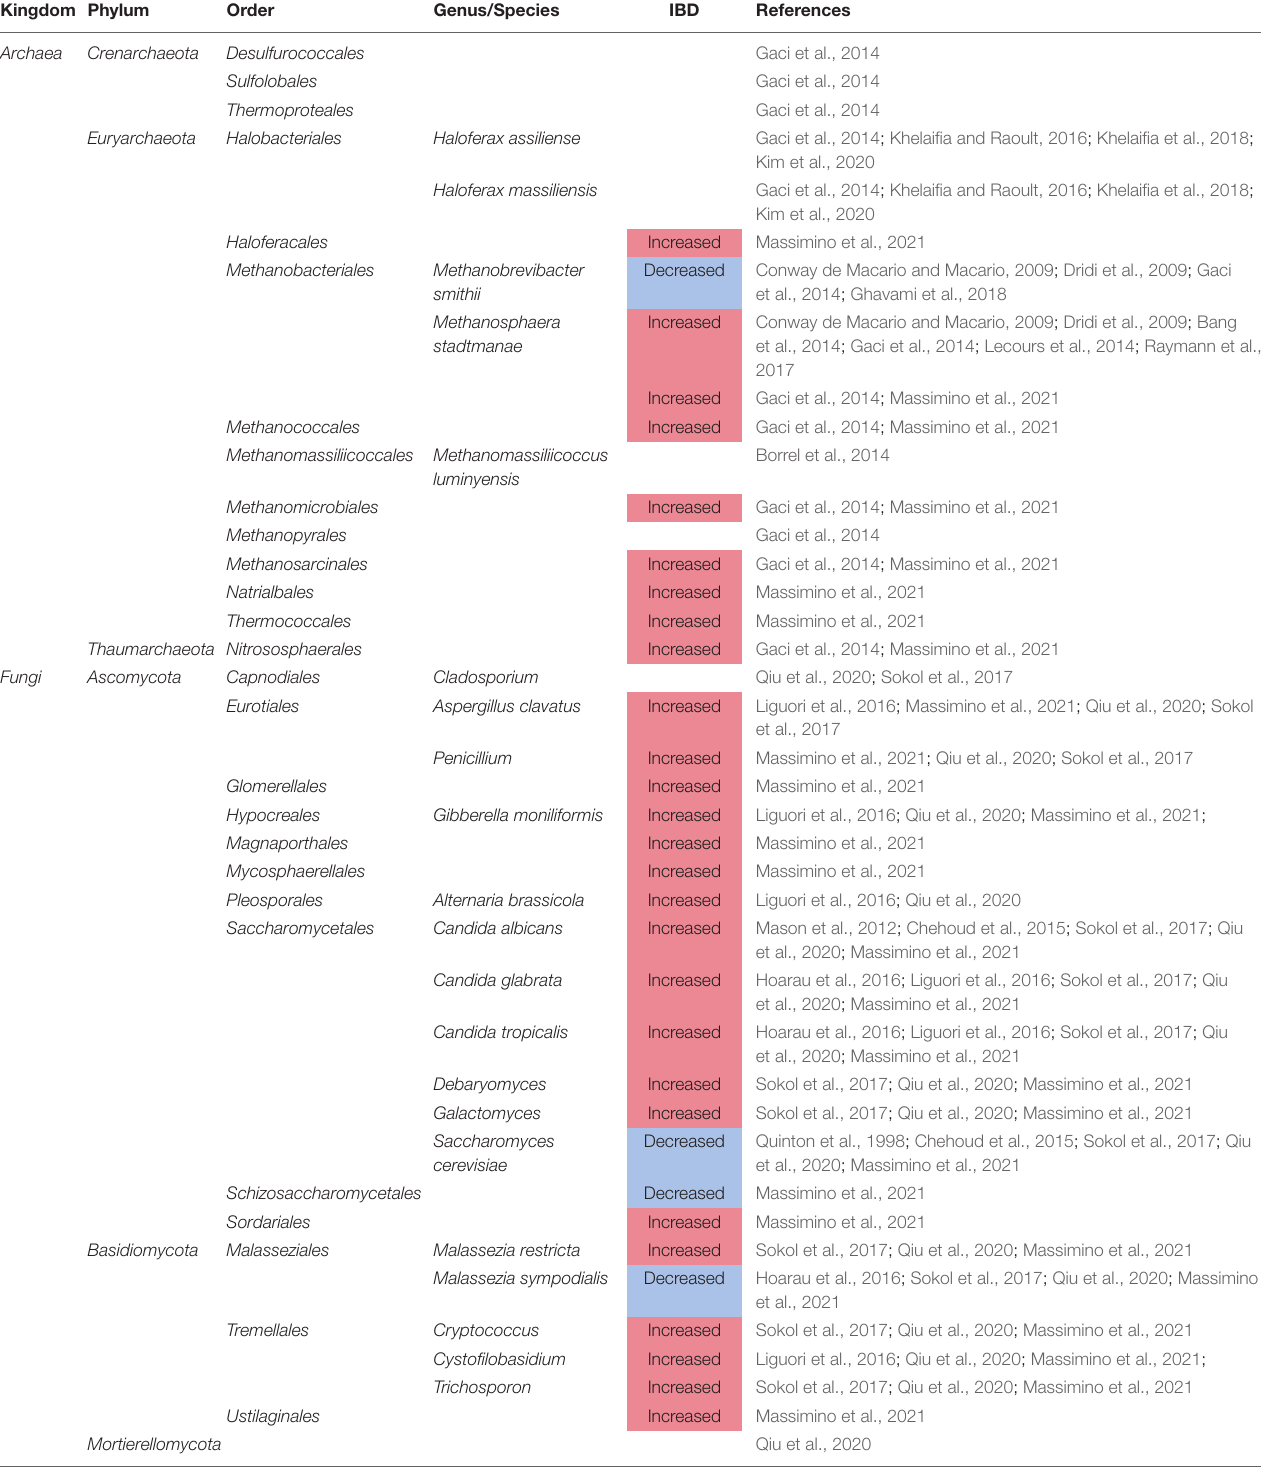
TABLE 1 | Microbiota composition in healthy and IBD